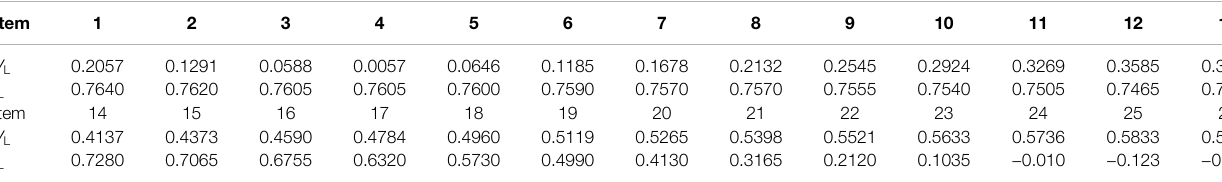
TABLE 4 | I-V data set of the benchmark experiment.